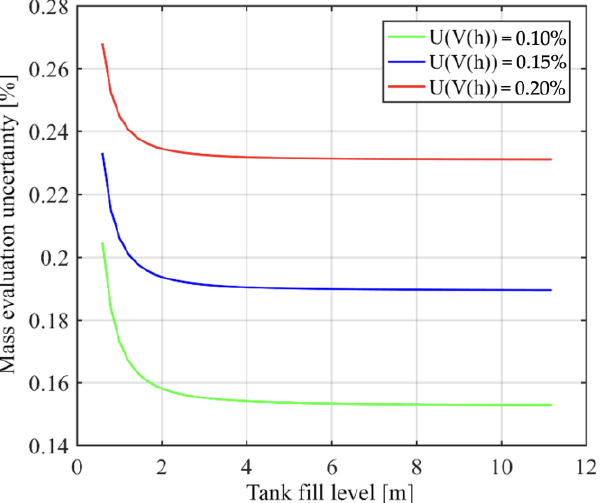
Figure 2. Dependence of the expanded uncertainty (relative form) of the product mass in the tank on the uncertainty of the tank graduation table ( U ( V ( h )) is the expanded calibration uncertainty of the tank from the calibration certificate.